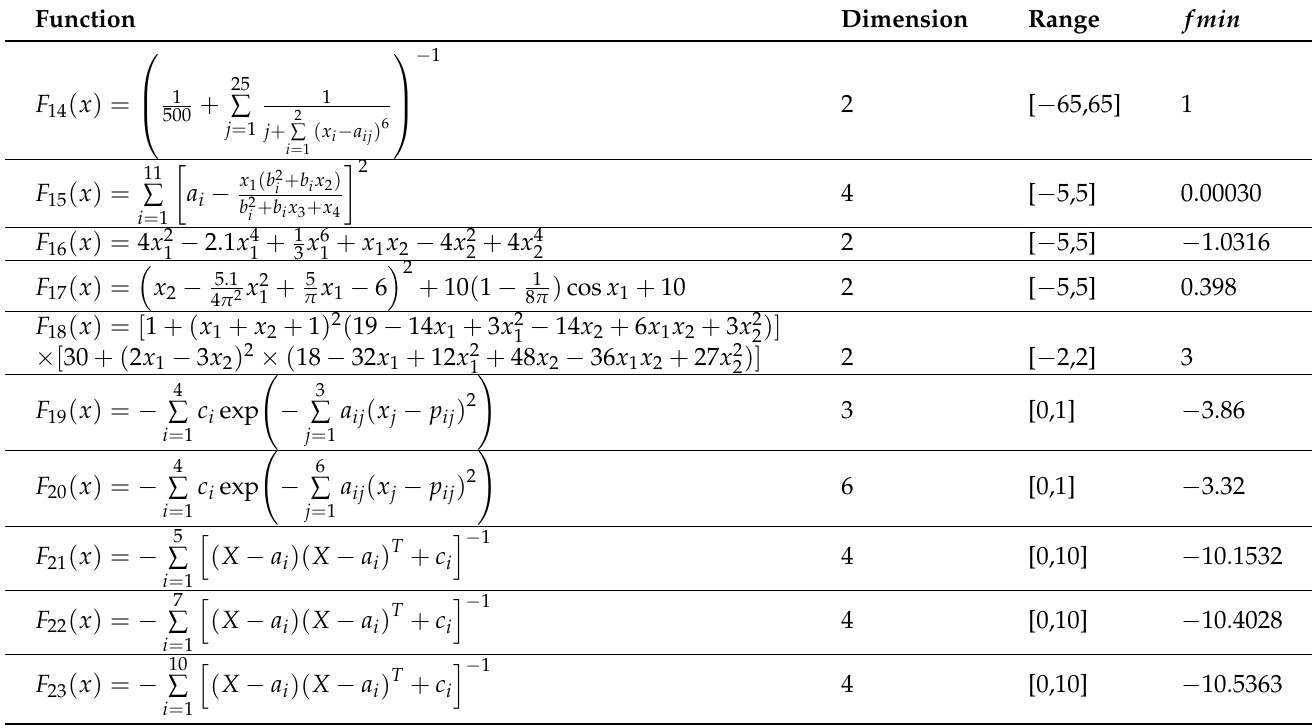
Table A3. Information on fixed-dimension benchmark